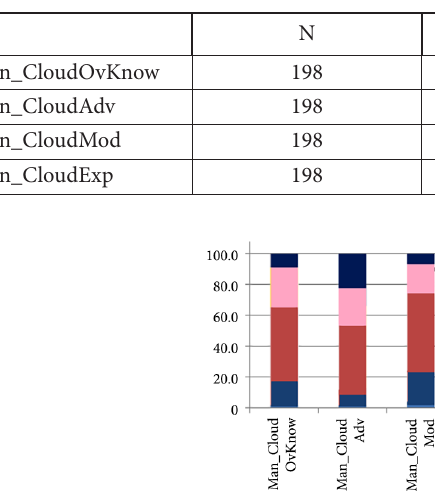
Table 6. Descriptive statistics for the variable managers’ cloud expertise